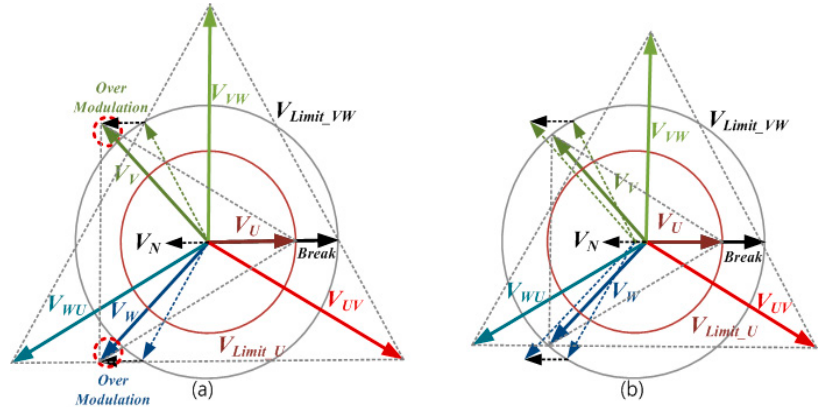
Figure 4. Conventional neutral-point voltage-shifting control of single U phase stack failure ( a ) over-modulation operation, ( b ) considering the maximum voltage source.